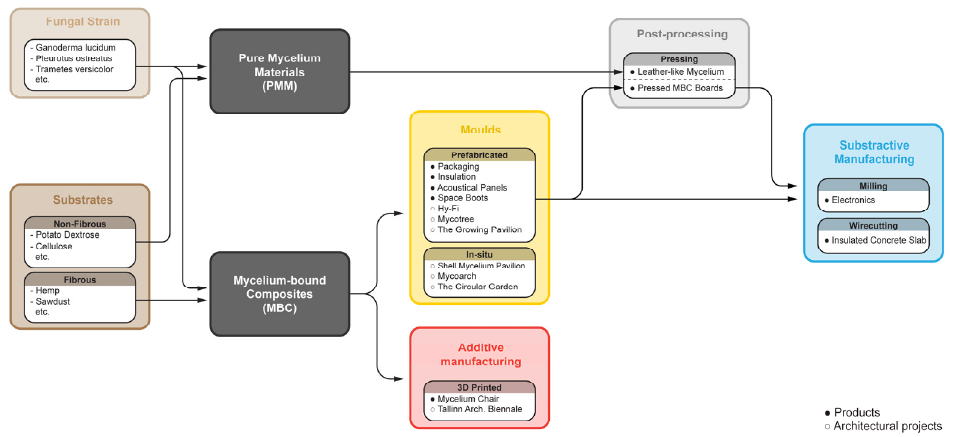
Figure 6. Overview of mycelium-based material typologies and applications.